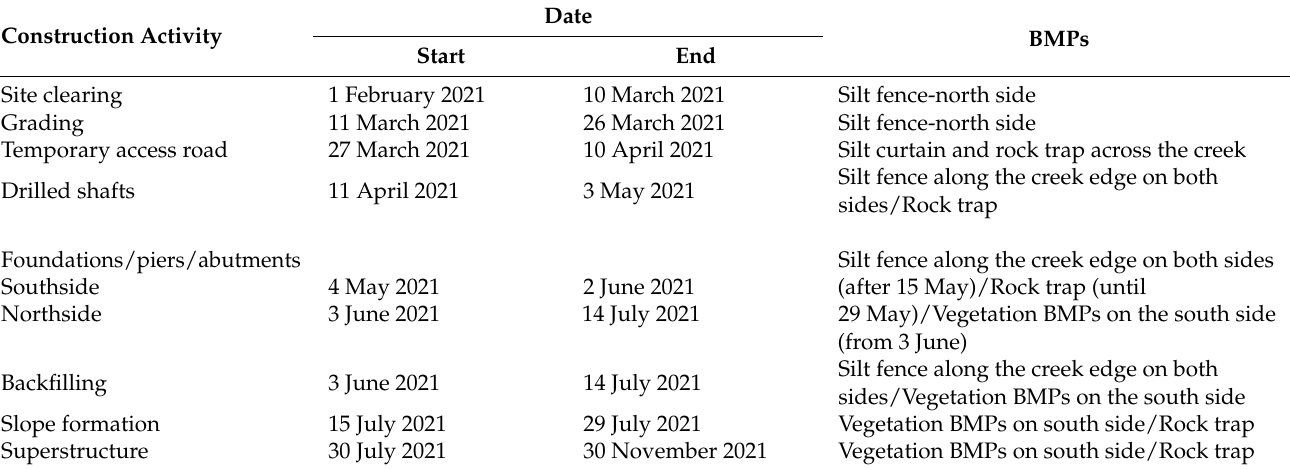
Table 2. Wilson Creek Bridge Construction Activities and Implemented